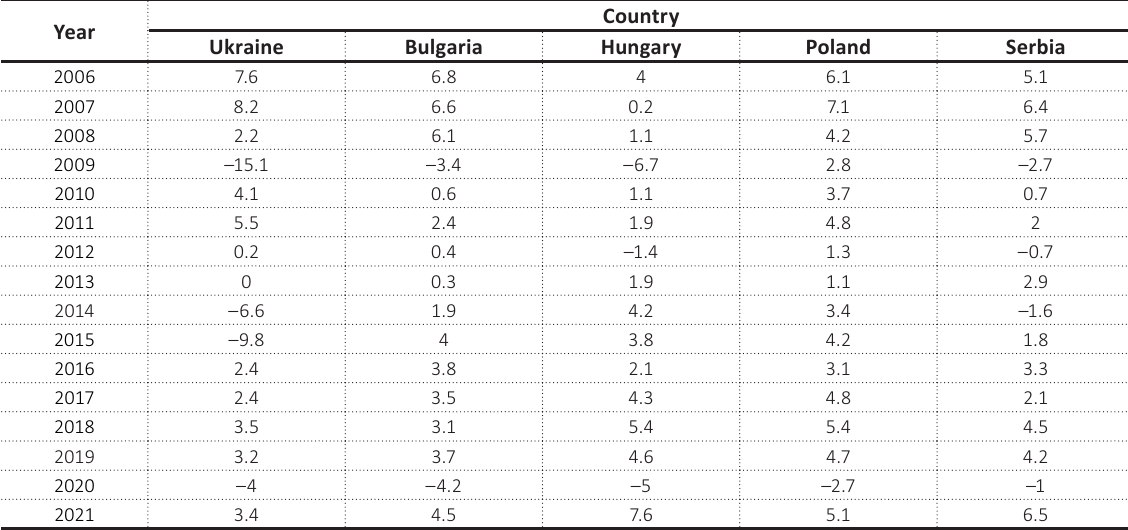
Source: IMF WEO (2022).